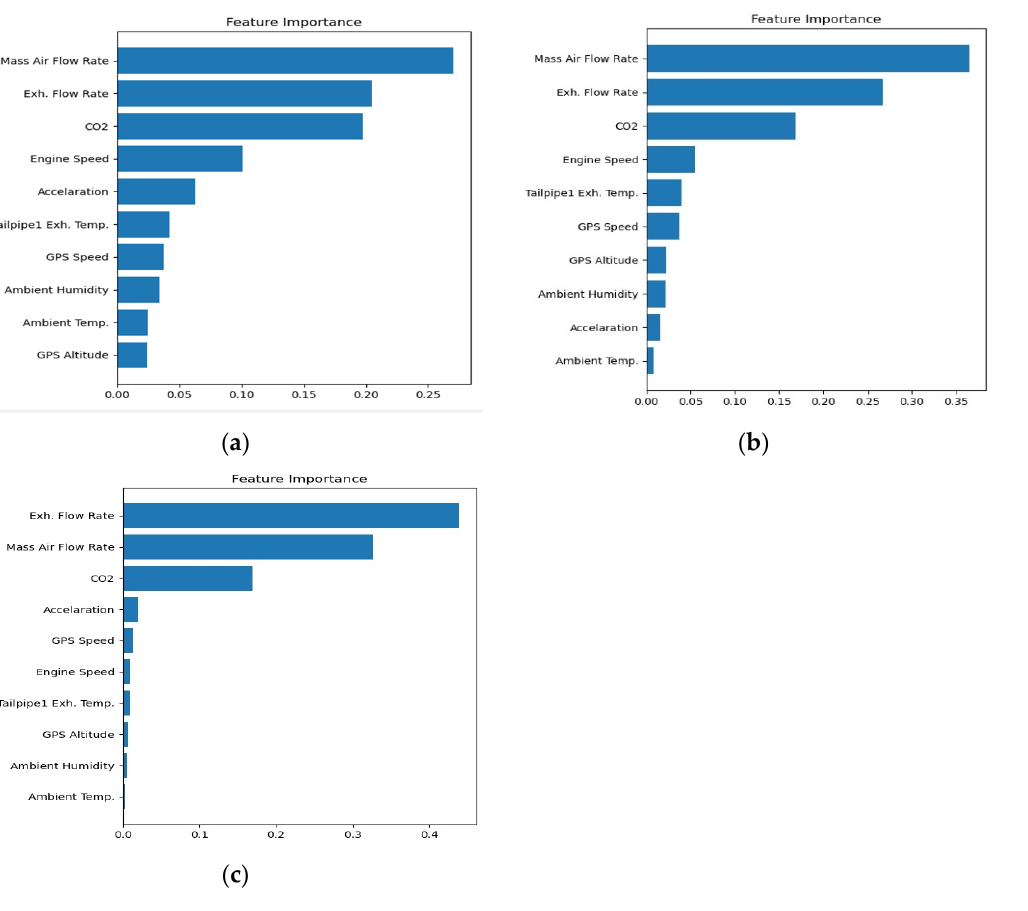
Figure 6. Feature importance detailed scores of NO x model ( a ) Urban; ( b ) Suburbs; ( c ) Highway. Table 7. Feature importance rank of NO x model in urban, suburbs, and highway. Rank Feature Urban Suburbs Highway